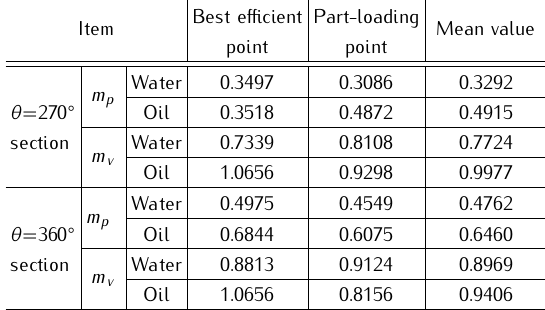
Table 2. Decay power of amplitude of pressure and velocity heads in two sections of volute.